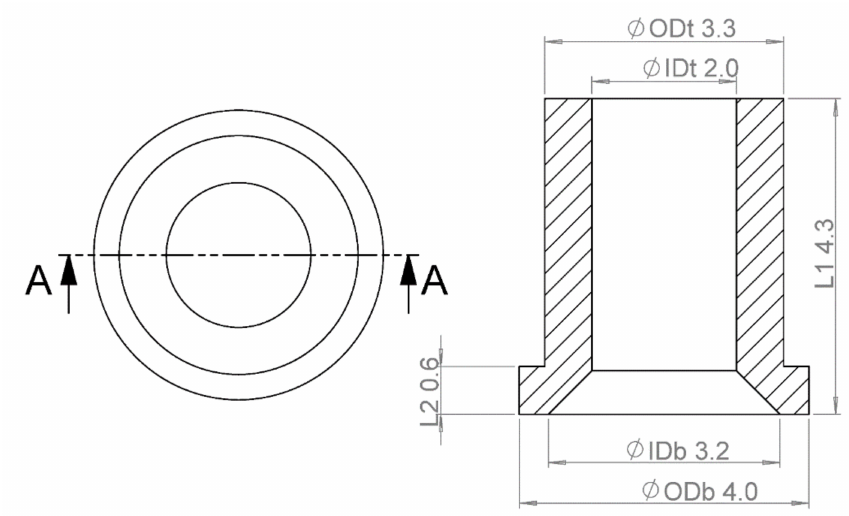
Figure 1. Micro part with main geometries indicated. The nominal dimensions in mm are shown.